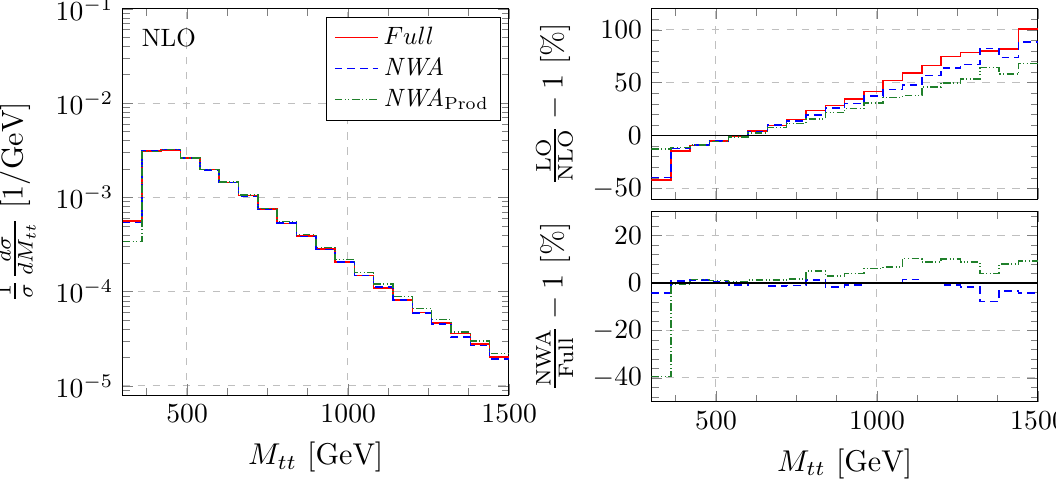
Figure 17 . Normalised M di(cid:11)erential distribution at NLO QCD for the pp t (cid:22) t X production process at the LHC with p s = 13 TeV. Three di(cid:11)erent theoretical descriptions with m t = 173.2 GeV are shown. Also given are the relative size of NLO QCD corrections and the combined relative size of (cid:12)nite-top-width and (cid:12)nite-W-width e(cid:11)ects for the normalised M observable. Renormalisation and factorisation scales are set to the common value (cid:22) R = (cid:22) F = (cid:22) 0 where (cid:22) 0 = m t . The CT14 PDF set is employed.